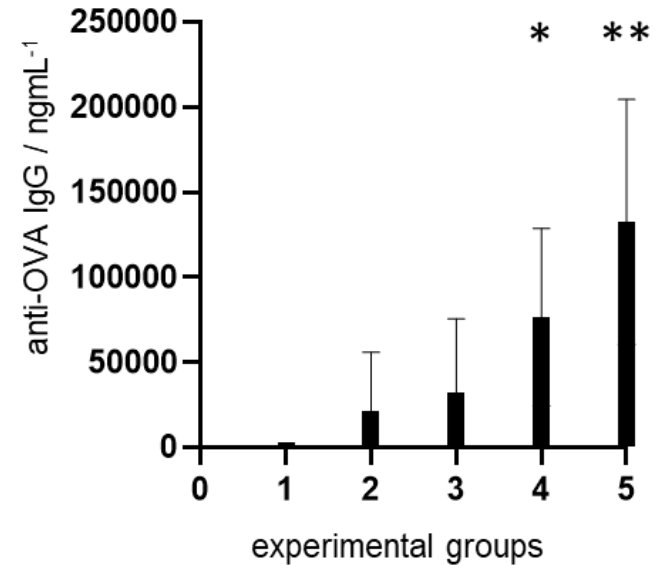
Figure 2. The effect of synthesized DMPs on the production of anti-OVA IgG in BALB/c mice immunized with OVA as an antigen. Experimental groups: 1 — control group,; 2 — OVA alone; 3 — OVA + ManAdDMP; 4 — OVA + 8 ; 5 — OVA + 14 . Bar graphs represent average values from individual mice from each group ( n = 5). * p < 0.05 and ** p < 0.01 denote statistical significance in comparison to the control group.